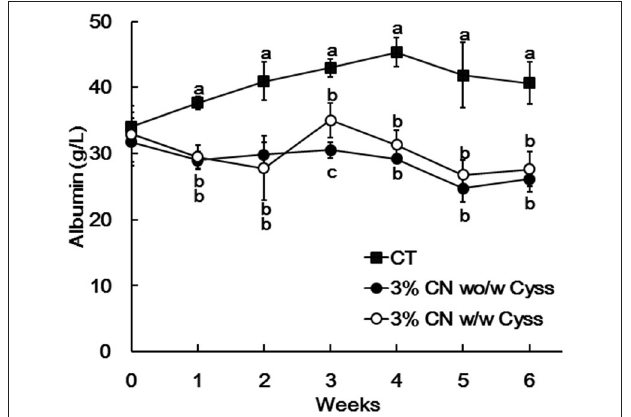
FIGURE 6 | Plasma mercaptalbumin ratio in Experiment 2. Plasma samples, obtained weekly, were subjected to HPLC to determine albumin redox state. Ratios of mercaptalbumin (MA) among total albumin are shown as means ± SD ( n = 6); values with different letters are significantly different at each time point ( P < 0.05). CN, CT, and Cyss denote casein, control, and cystine,